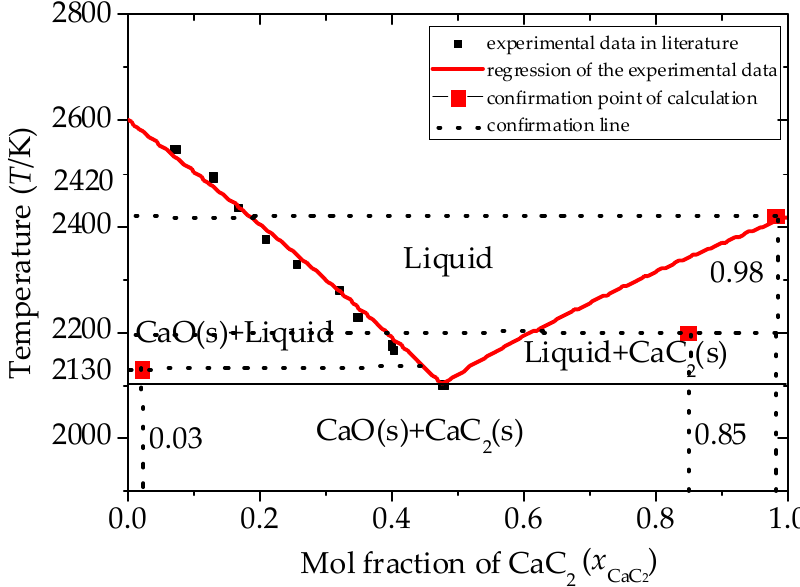
Figure 15. Confirmation of the calculation (Liquid contains CaO (L) and CaC 2 (L)).